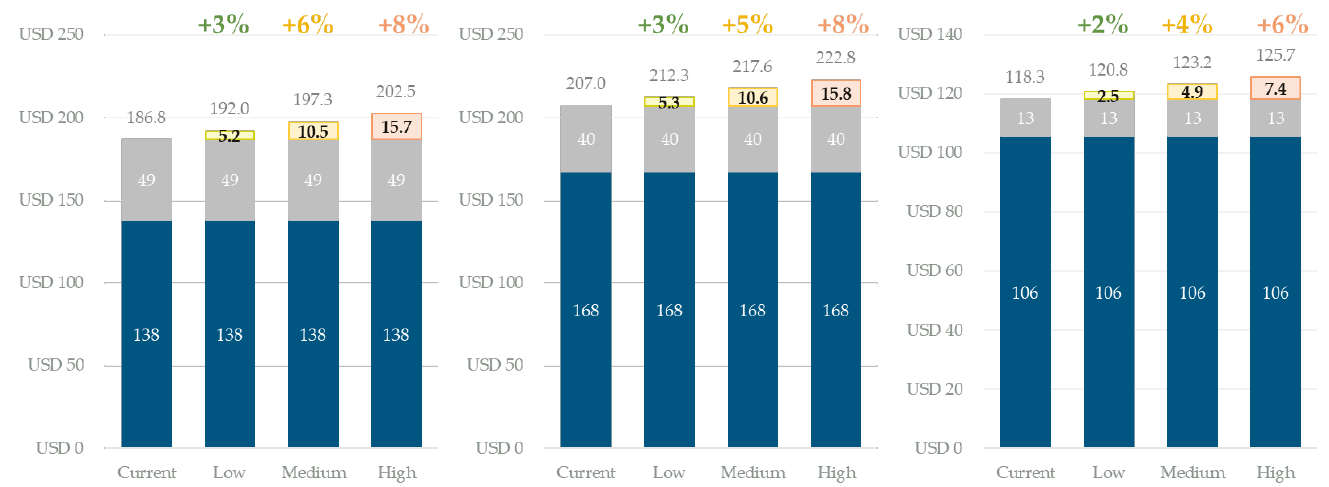
Figure 8. The impact of the carbon tax under various charging levels on trading prices for iron ore ( Left : Brazil, Middle : South Africa; Right : India). Notes: In October 2021, the highest freight rates for iron ore imports from Brazil and South Africa to China were 48.55 USD/ton (Tubarao – Qingdao) and 39.5 USD/ton (Saldanha – Qingdao), while the shipping cost from India was estimated at 12.5 USD/ton (Goa – Qingdao, Jan 2021). The average trading prices of iron ore were estimated at 138.25 USD/ton, 167.5 USD/ton, and$105.78 USD/ton, respectively. Source: Shanghai Shipping Exchange.